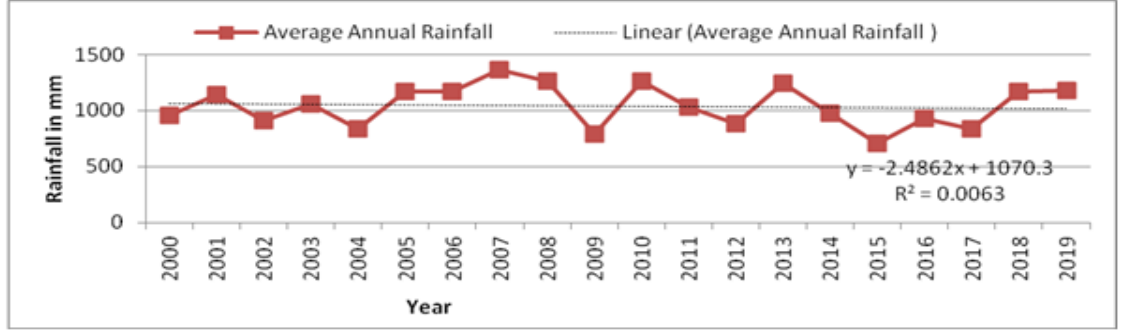
Average Annual Rainfall for Lowlands of Wolaita Zone